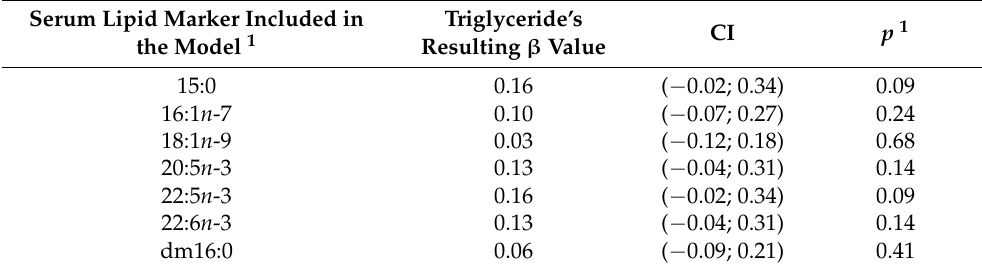
Table 3. Association strength ( β and CI) of serum triglycerides levels with MA, when MA-associated lipid metabolite markers were included in the model.